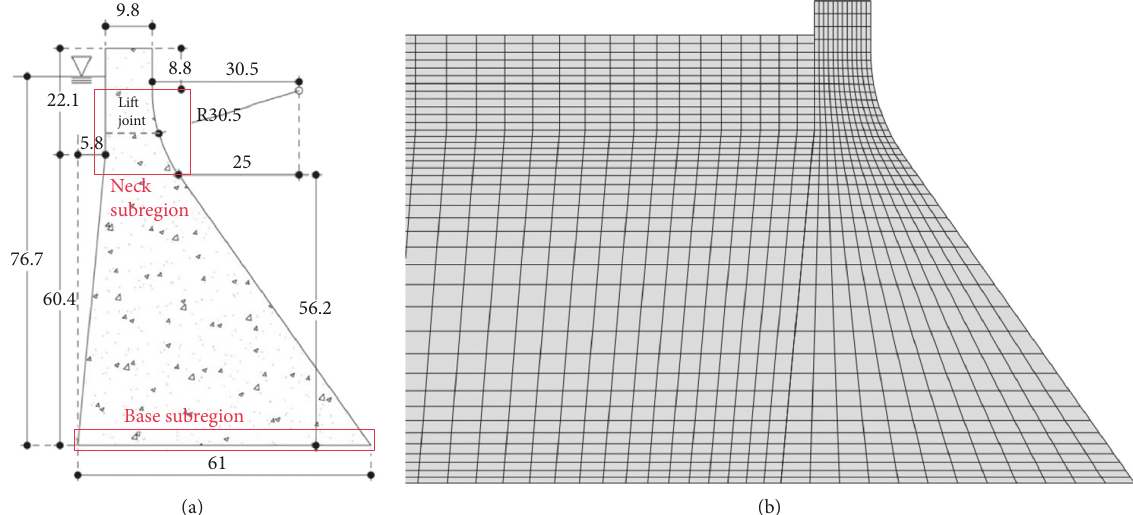
Figure 1: (a) The tallest nonoverflow monolith of Folsom gravity dam, the shown dimensions are in meters. (b) The finite-element discretized mesh of the dam and part of the reservoir.